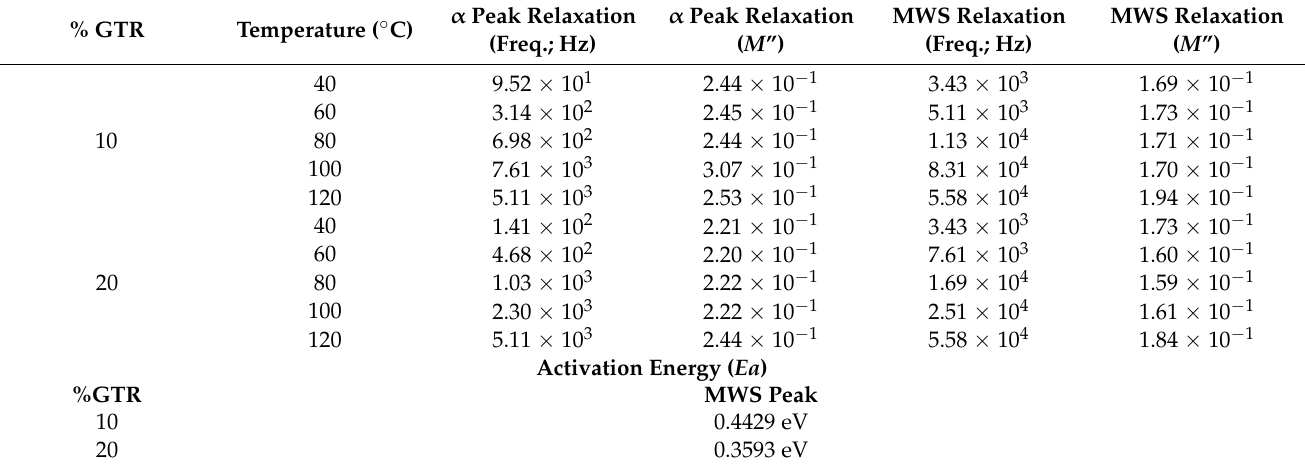
Table 3. Evolution of Peak β and Maxwell-Wagner-Sillars (MWS) Relaxations, for EPDM composites with 10 and 20% GTR amounts in EPDM composites, at 50 Hz, and evolution of activation energies (E a ) for 10 and 20% of GTR contents in EPDM composites.